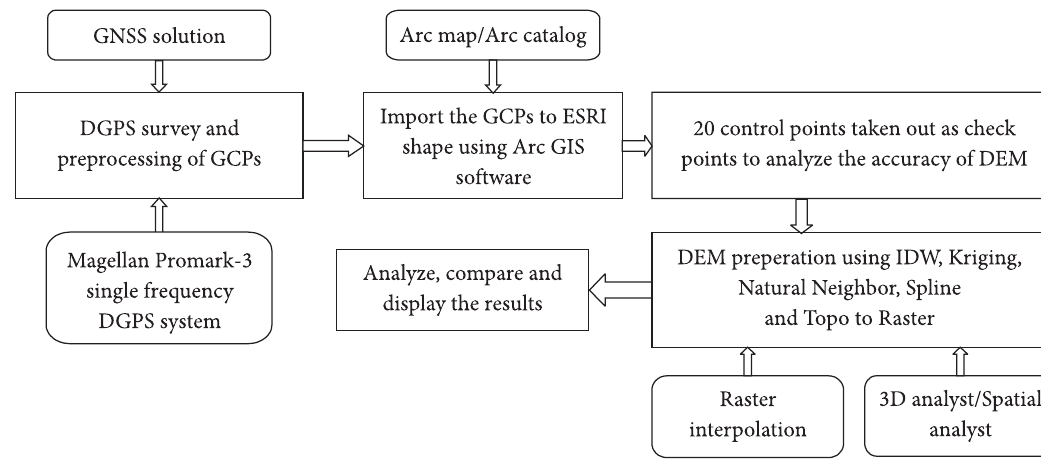
Fig. 1. Methodology for comparative analysis of interpolation